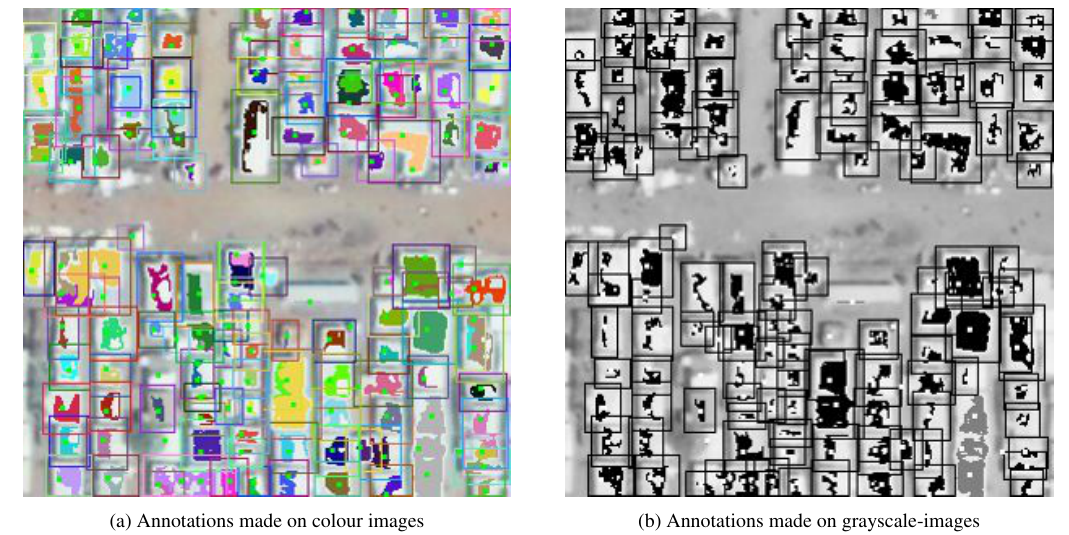
Figure 1. Example of the two annotation modes. The annotations shown are made on a satellite image of the Juba camp, South Sudan text of the HUMAN+ 1 project. In the HUMAN+ project, a